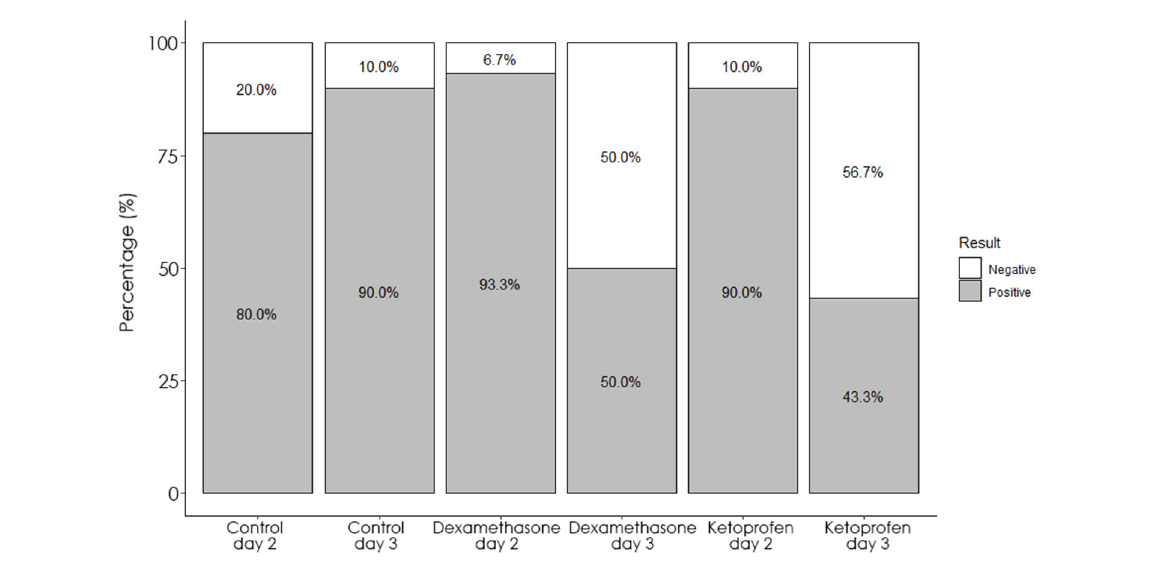
FIGURE3 Percentage of animals that were positive (gray) and negative (white) to SIT test in the dexamethasone, ketoprofen and control groups at day 2 and day